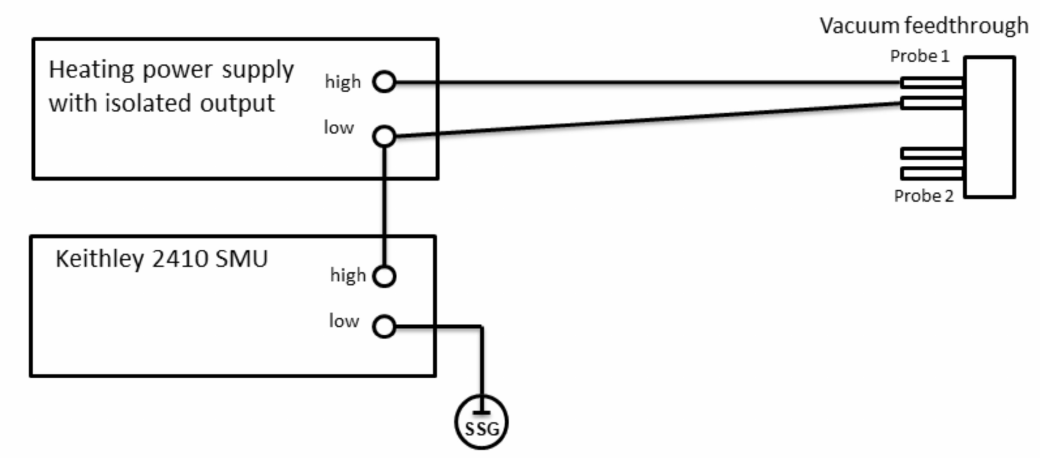
Figure 6. Electrical scheme of emissive probes.